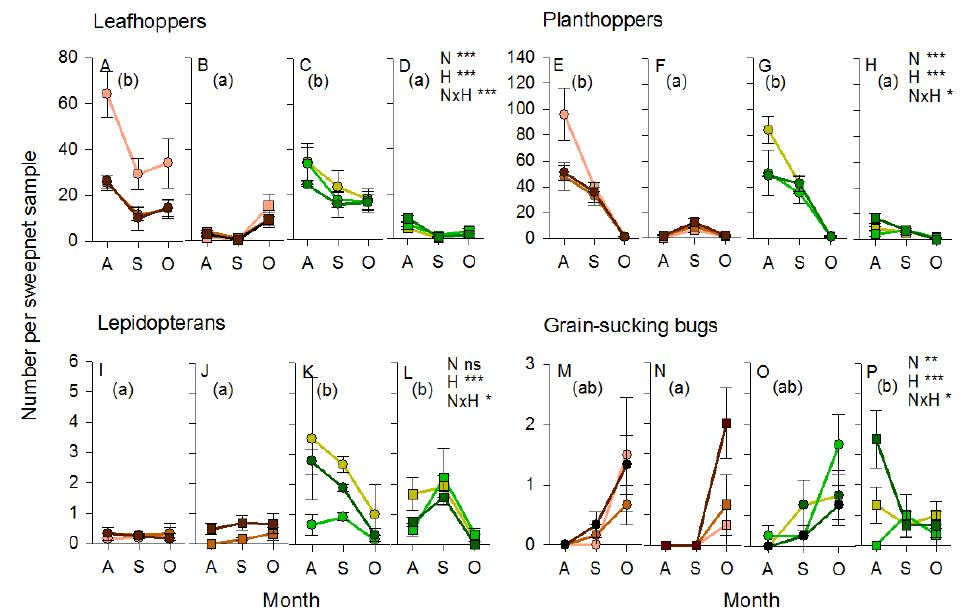
Figure 6. Relative abundance of principal rice herbivores from sweepnet sampling of rice plots during August (A), September (S) and October (O) of 2013. Samples from clear bunds and adjacent rice are indicated by brown lines and symbols with samples from mung bean bunds and adjacent rice indicated by green lines and symbols. The abundance of leafhopper vectors of tungro virus ( A – D ), planthoppers ( E – H ), lepidopterans including stemborers and leaffolders ( I – L ), and grain sucking bugs ( M – P ) are indicated. Plots were planted with IR64 and received one of three nitrogen-fertilizer treatments (indicated by color intensity of points, N1 = light, N2 = medium, N3 = dark). Samples were collected from the rice crop (circles, A, C, E, G, I, K, M, O) and from bund vegetation (square symbols, B, D, F, H, J, L, N, P). Samples from rice were collected at < 3 m from clear bunds (A, E, I, M), or vegetable bunds (C, G, K, O). Standard errors are indicated ( n = 8). GLM results for the effects of nitrogen (N), habitat type (H) and their interactions (N × H) are indicated for each herbivore group; ns = p > 0.05, * = p < 0.05, ** = p < 0.01, *** = p < 0.001. Lowercase letters indicate homogenous habitat groups.